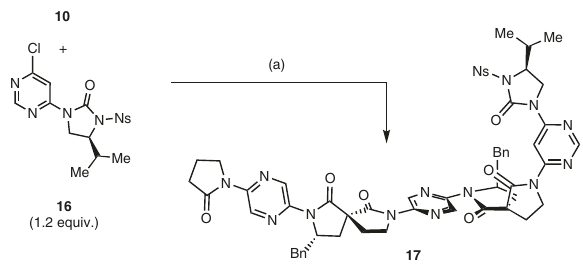
Fig. 6 Synthesis of hybrid spirolactam-imidazolidinone 17. a Pd 2 (dba) 3 (10 mol%), Xantphos (30 mol%), Cs 2 CO 3 (2.5 equiv.), PhMe, 80 °C, 2 h, 75%. Ns